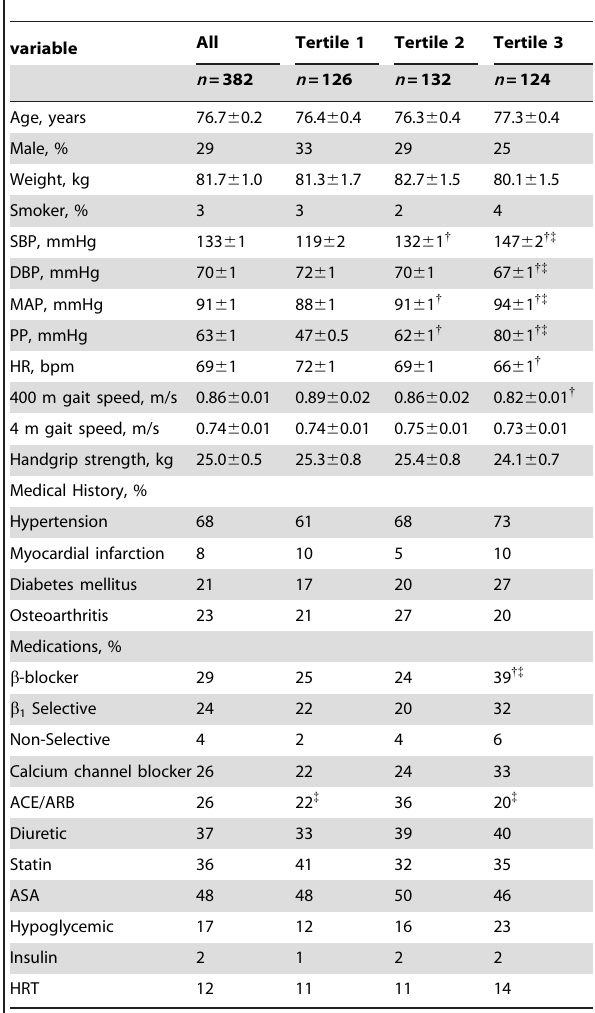
Table 1. Participant characteristics according to tertile of pulse